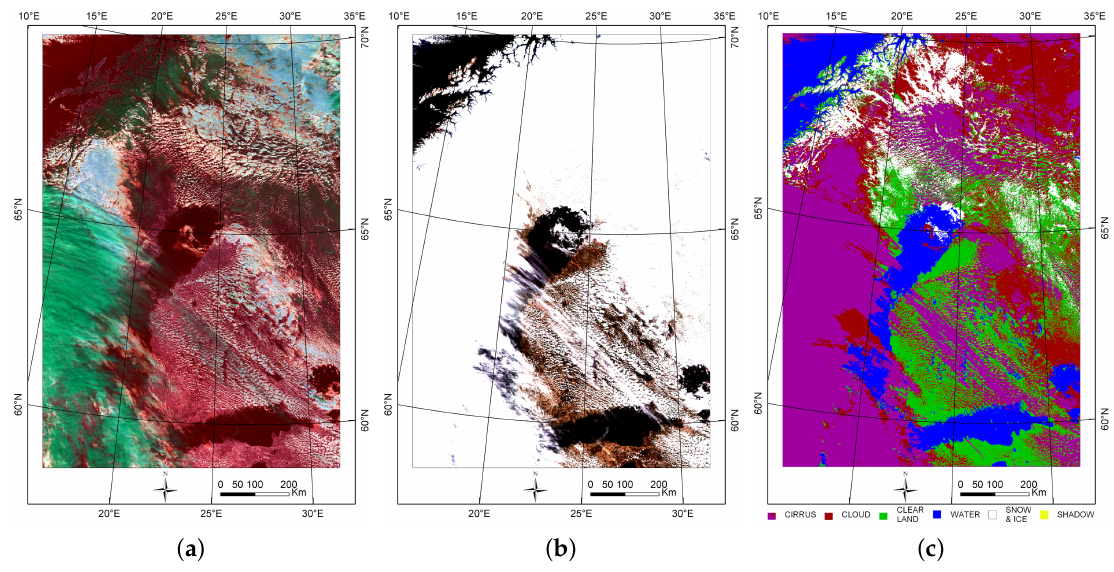
Figure 5. A Suomi NPP VIIRS image of 25 April 2015, at 10:28 a.m. ( a ) RGB from 3.7 µ m, 2.2 µ m and 1.6 µ m reflectance. ( a ) RGB composite from 3.7 µ m, 2.2 µ m and 1.6 µ m reflectance. ( b ) Natural colour image from 0.672 µ m, 0.555 µ m and 0.490 µ m reflectance. ( c ) Cloud and shadow detection result.